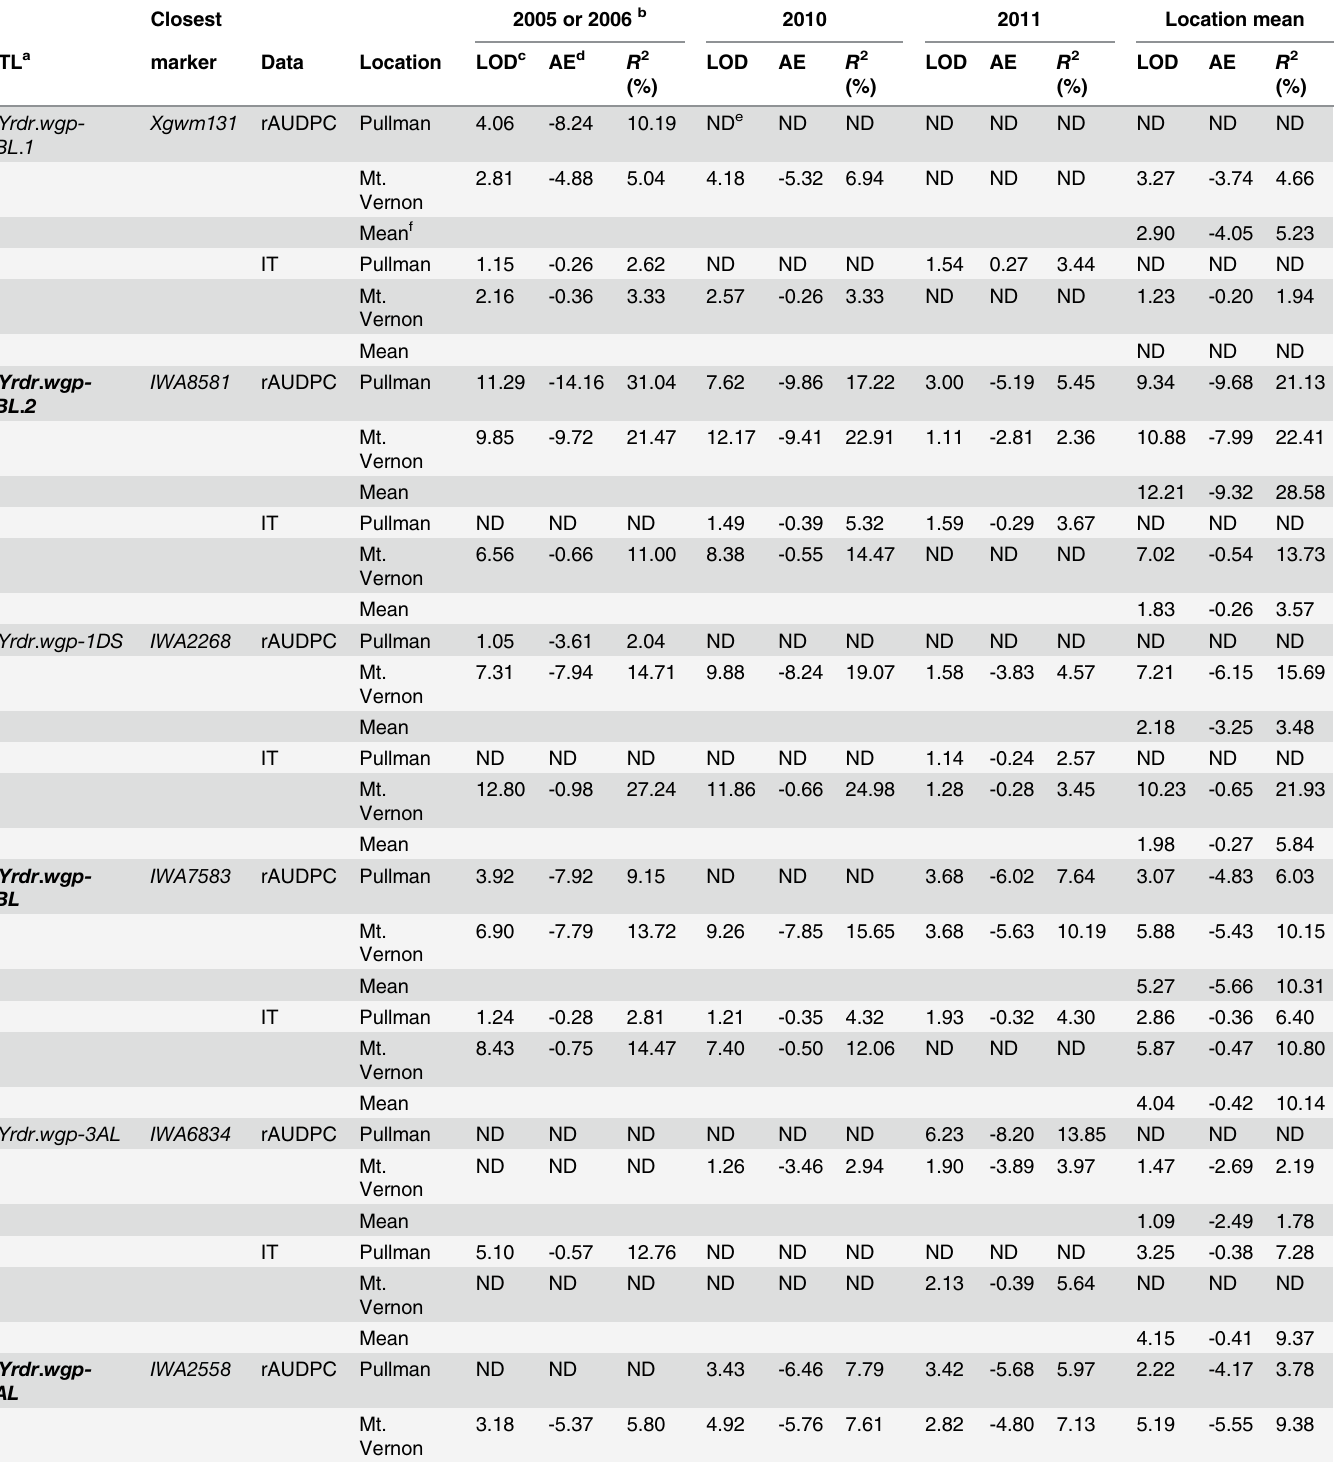
Table 5. Quantitative trait loci for stripe rust resistance for the relative area under the disease progress curve (rAUDPC) and infection type (IT) in the Druchamp × Michigan Amber derived recombinant inbred line population in 2006, 2010 and 2011 at Pullman and in 2005, 2010 and 2011 at Mt.